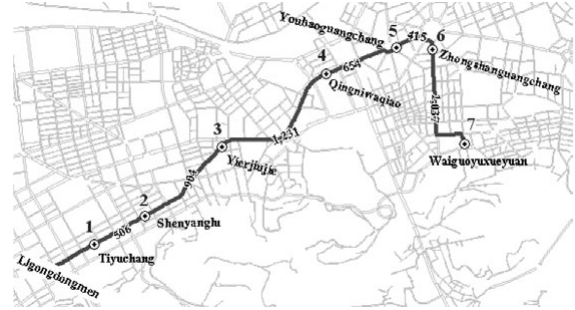
Fig. 7. The configuration of transit route No 23